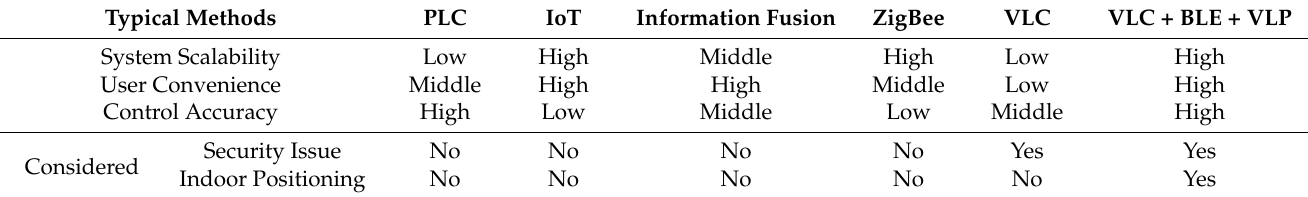
Table 2. Comparison of typical methods adopted in smart home control